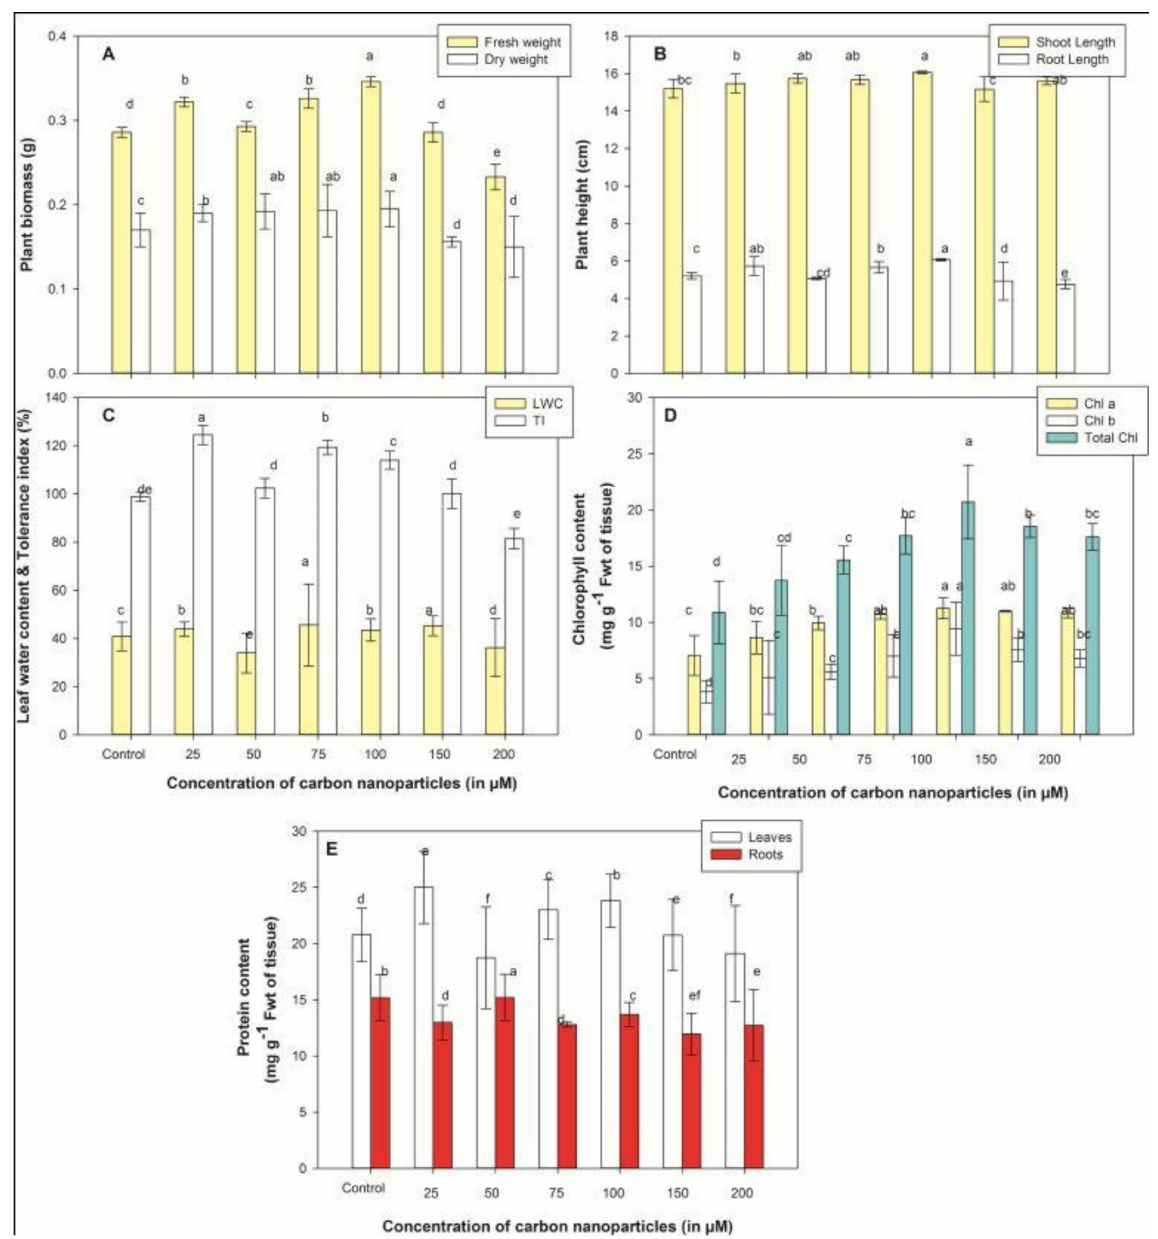
Figure 2. Plant biomass ( A ), plant height ( B ), leaf water content and tolerance index ( C ), chlorophyll concentration ( D ) and protein content ( E ) in seedlings of V. radiata treated with various concentrations of CNPs, ranging from 25 to 200 µ M. Values are mean ± standard deviation ( n = 3) and are statistically significant according to the DMRT test ( p < 0.05). Data points marked with the same letters show insignificant differences ( p < 0.05) within